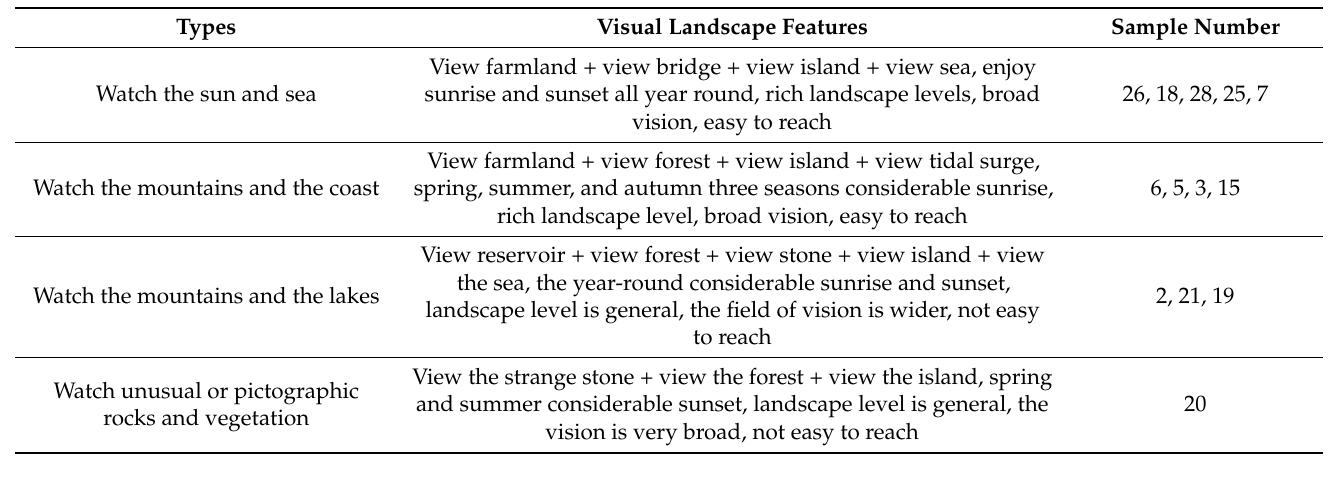
Table 7. Visual landscape classification of scenic viewpoints.